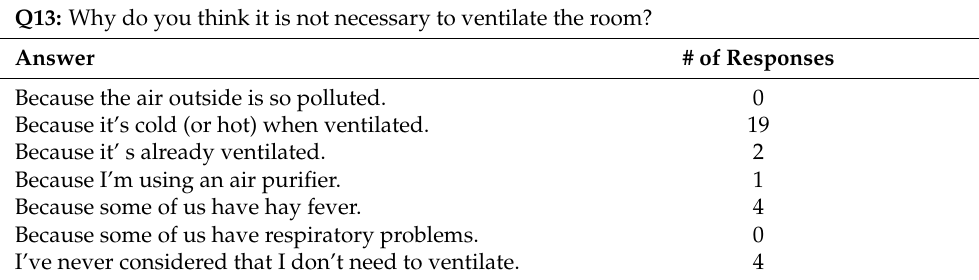
Table 6. Answers to a question about when ventilation is not needed (multiple answers